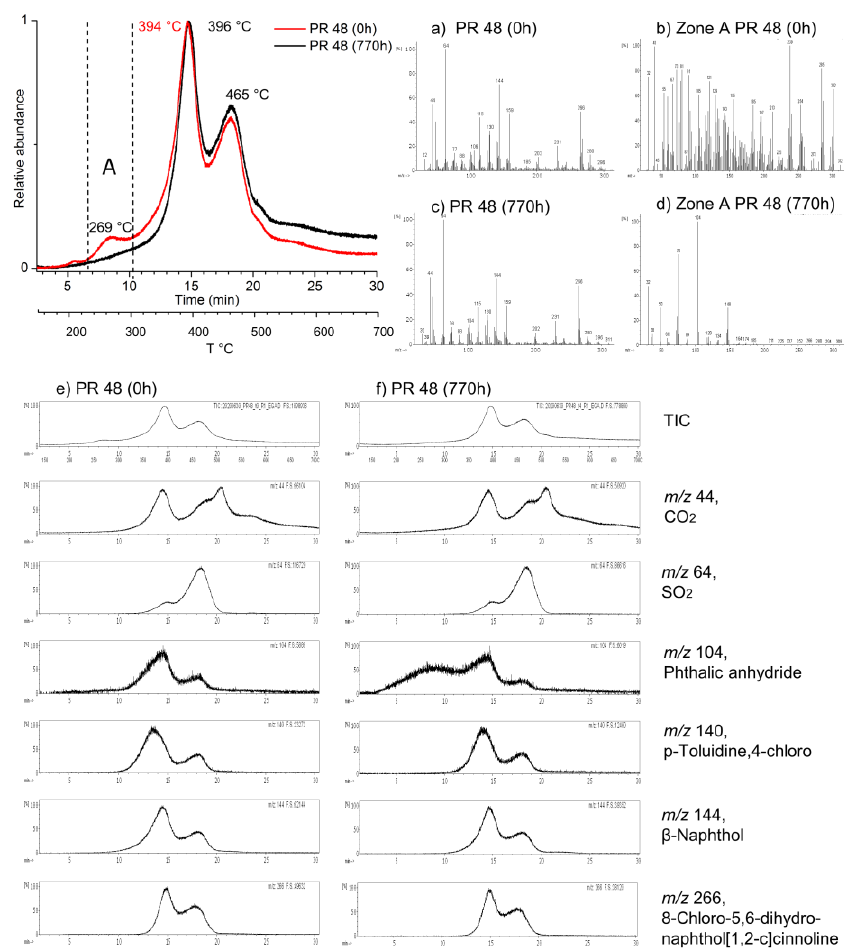
4 Figure 4. EGA-curves of the pigment PR 48:2 at 0 h (no aging) and at 770 h and related mass spectra: ( a ) average mass spectrum of PR 48:2 at 0 h, ( b ) average mass spectrum of zone A for PR 48:2 at 0 h, ( c ) average mass spectrum of PR:2 48 at 770 h, ( d ) average mass spectrum of zone A for PR 48:2 at 770 h, ( e ) total ion current (TIC) and extracted ions for PR 48:2 at 0 h, and ( f ) total ion current (TIC) and extracted ions for PR 48:2 at 770 h. The ion trends are scaled to the largest peak in each